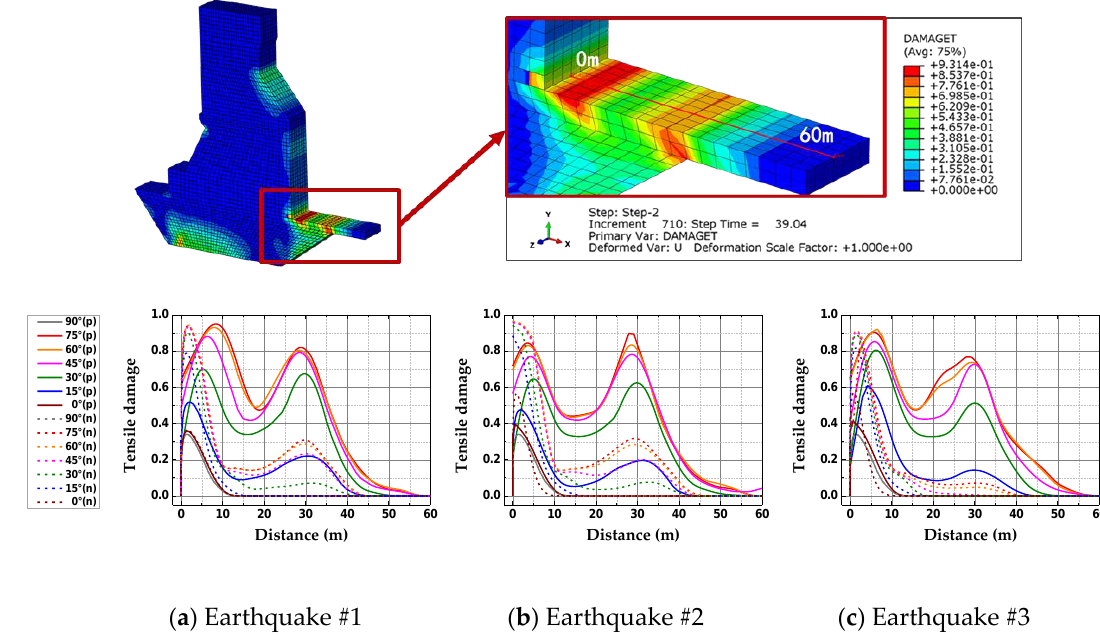
Figure 14. The spatial variation of dam body tensile damage.